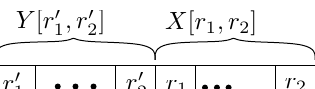
Figure 1. Maximal unstable communication period Y [ r (cid:48) period X [ r 1 , r 2 ] . where r 1 = r (cid:48)